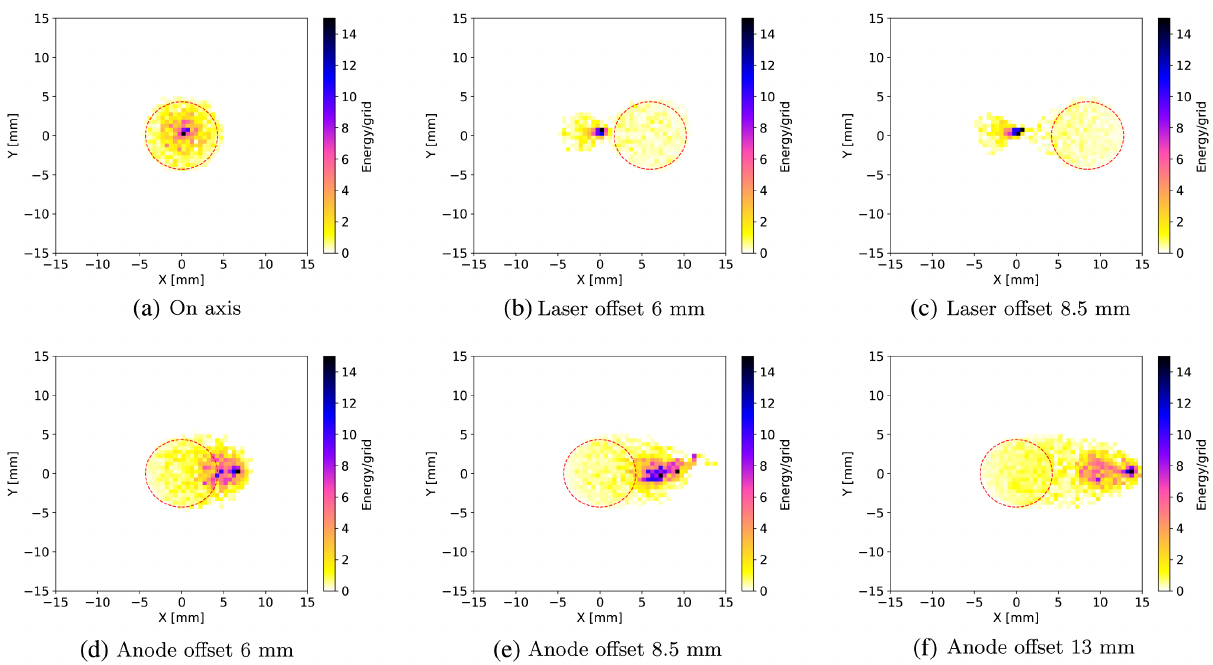
FIG. 8. Power deposited on the cathode due to ion back bombardment for various anode and laser offsets. The power deposition is calculated on 0.5 mm X 0.5 mm grids and normalized to the maximum power deposited in any grid. The red dotted circle represents the laser spot. Electrostatic center for the cathode is at (0,0). The color bar represents the normalized power deposited, white being no power and black being maximum power.